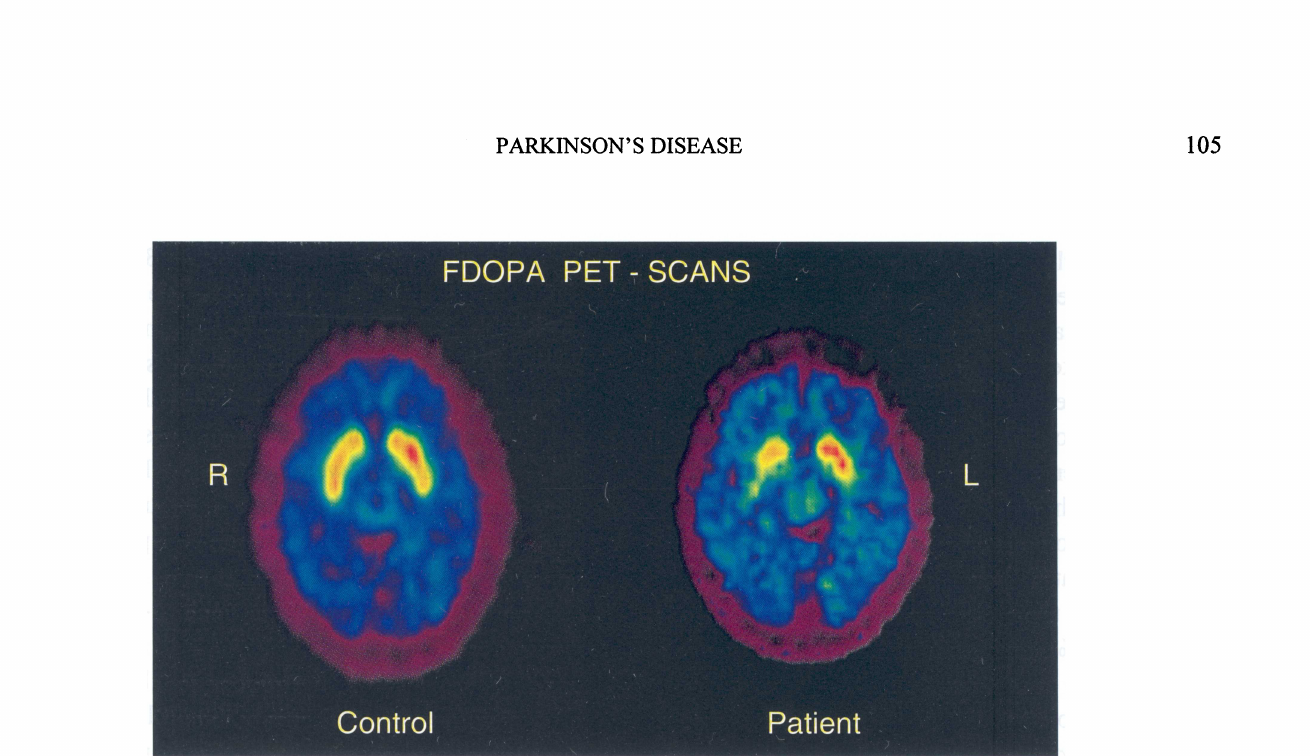
Fig. I" Transaxial representation of cerebral FDOPA uptake in one healthy volunteer (left panel) and one PD patient (right panel). The front ofthe brain is on the top of the image. Specific uptake of tracer (see text) is indicated by a linear color scale, red being maximal uptake. The striatum on both sides of the brain is indicated by the high intensity uptake of tracer in the healthy volunteer. It can be seen that in the PD patient the uptake into striatum is diminished, particularly in the more posterior regions.